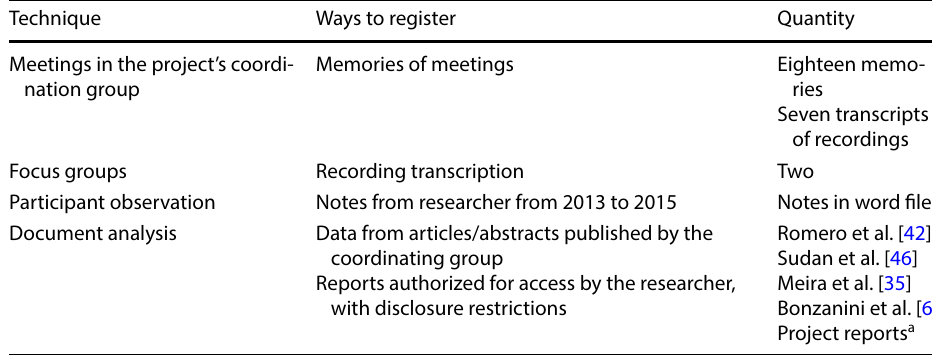
Table 1 Data collection techniques for research Source: elaborated by the authors with data from